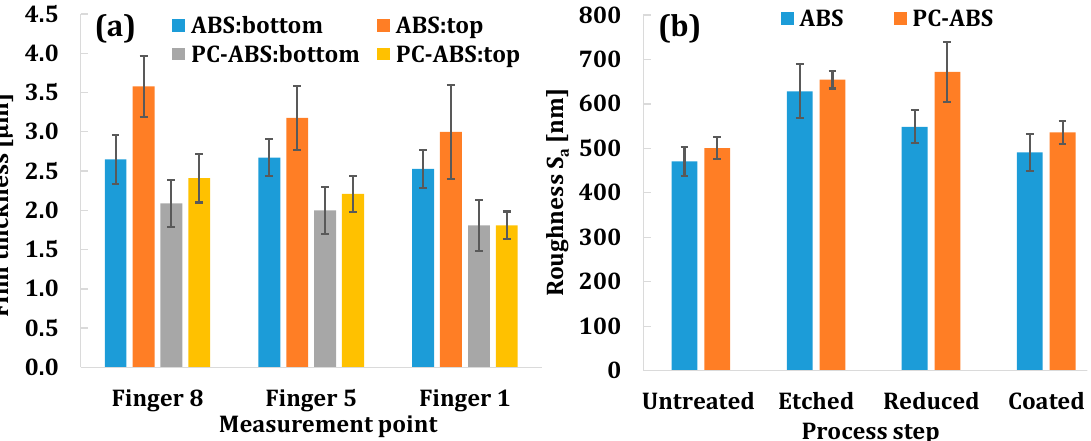
Figure 9. Thickness of the copper film on different fingers and finger heights ( a ); comparison of the surface roughness of plastic substrates after different preparation steps ( b ).